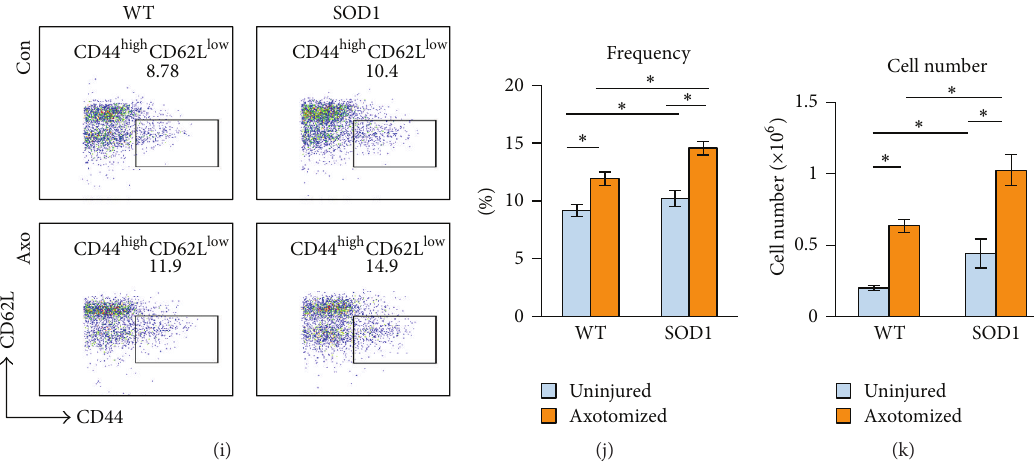
Figure 1: Inflammation and CD4 T cell activation in SOD 1 G 93 A mice. (a) Cervical lymph nodes were collected from uninjured (Con) and axotomized WT and SOD 1 G 93 A mice at 7, 9, and 14 dpa. The average of total number of dCLN from one mouse was calculated and compared ( 𝑛 = 4 mice/group). (b) dCLN from 3 individual mice in each group were collected and photographed on 7dpa (the underline denotes the horizontal dimension of each dCLN). (c) dCLN were gated on T cells (CD3 + cells) and further analyzed for their subsets: CD4 + and CD8 + T cells. (d) the average of CD4 + and CD8 + T cell percentages in each group was calculated and compared. (e) The total numbers of CD4 + and CD8 + T cells were calculated on the basis of the total number of corresponding dCLN and their percentages. (f) dCLN cells were gated on CD4 + T cells and analyzed for CD69 + cells (in the square gate). (g) the average of CD69 + cell percentages in each group was calculated and compared. (h) The total number of CD69 + cells was calculated on the basis of the total number of corresponding dCLN and their percentages. (i) dCLN cells were gated on CD4 + T cells and analyzed for CD 62 L low CD 44 high cells (in the square gate). (j) the average of CD 62 L low CD 44 high cell percentages in each group was calculated and compared. (k) The total number of CD 62 L low CD 44 high cells was calculated on the basis of the total number of corresponding dCLN and their percentages (data are presented as mean ± SD; 𝑛 = 4 mice/group, ∗ 𝑝 < 0.05 ; blue bars represent uninjured animals, whereas gold bars represent animals that have been subjected to